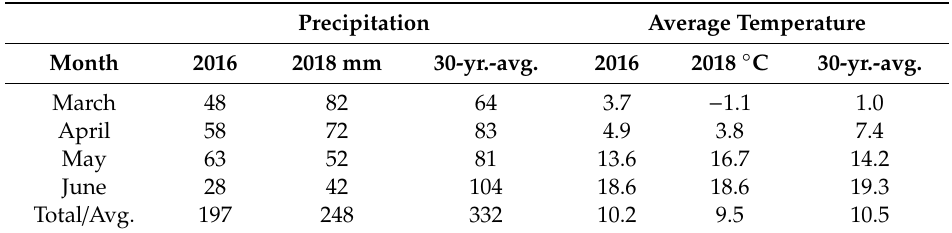
Table 2. Monthly and total precipitation, and monthly average temperatures during the spring of 2016 and 2018 at a University Research Farm in central New York, USA. Precipitation Average